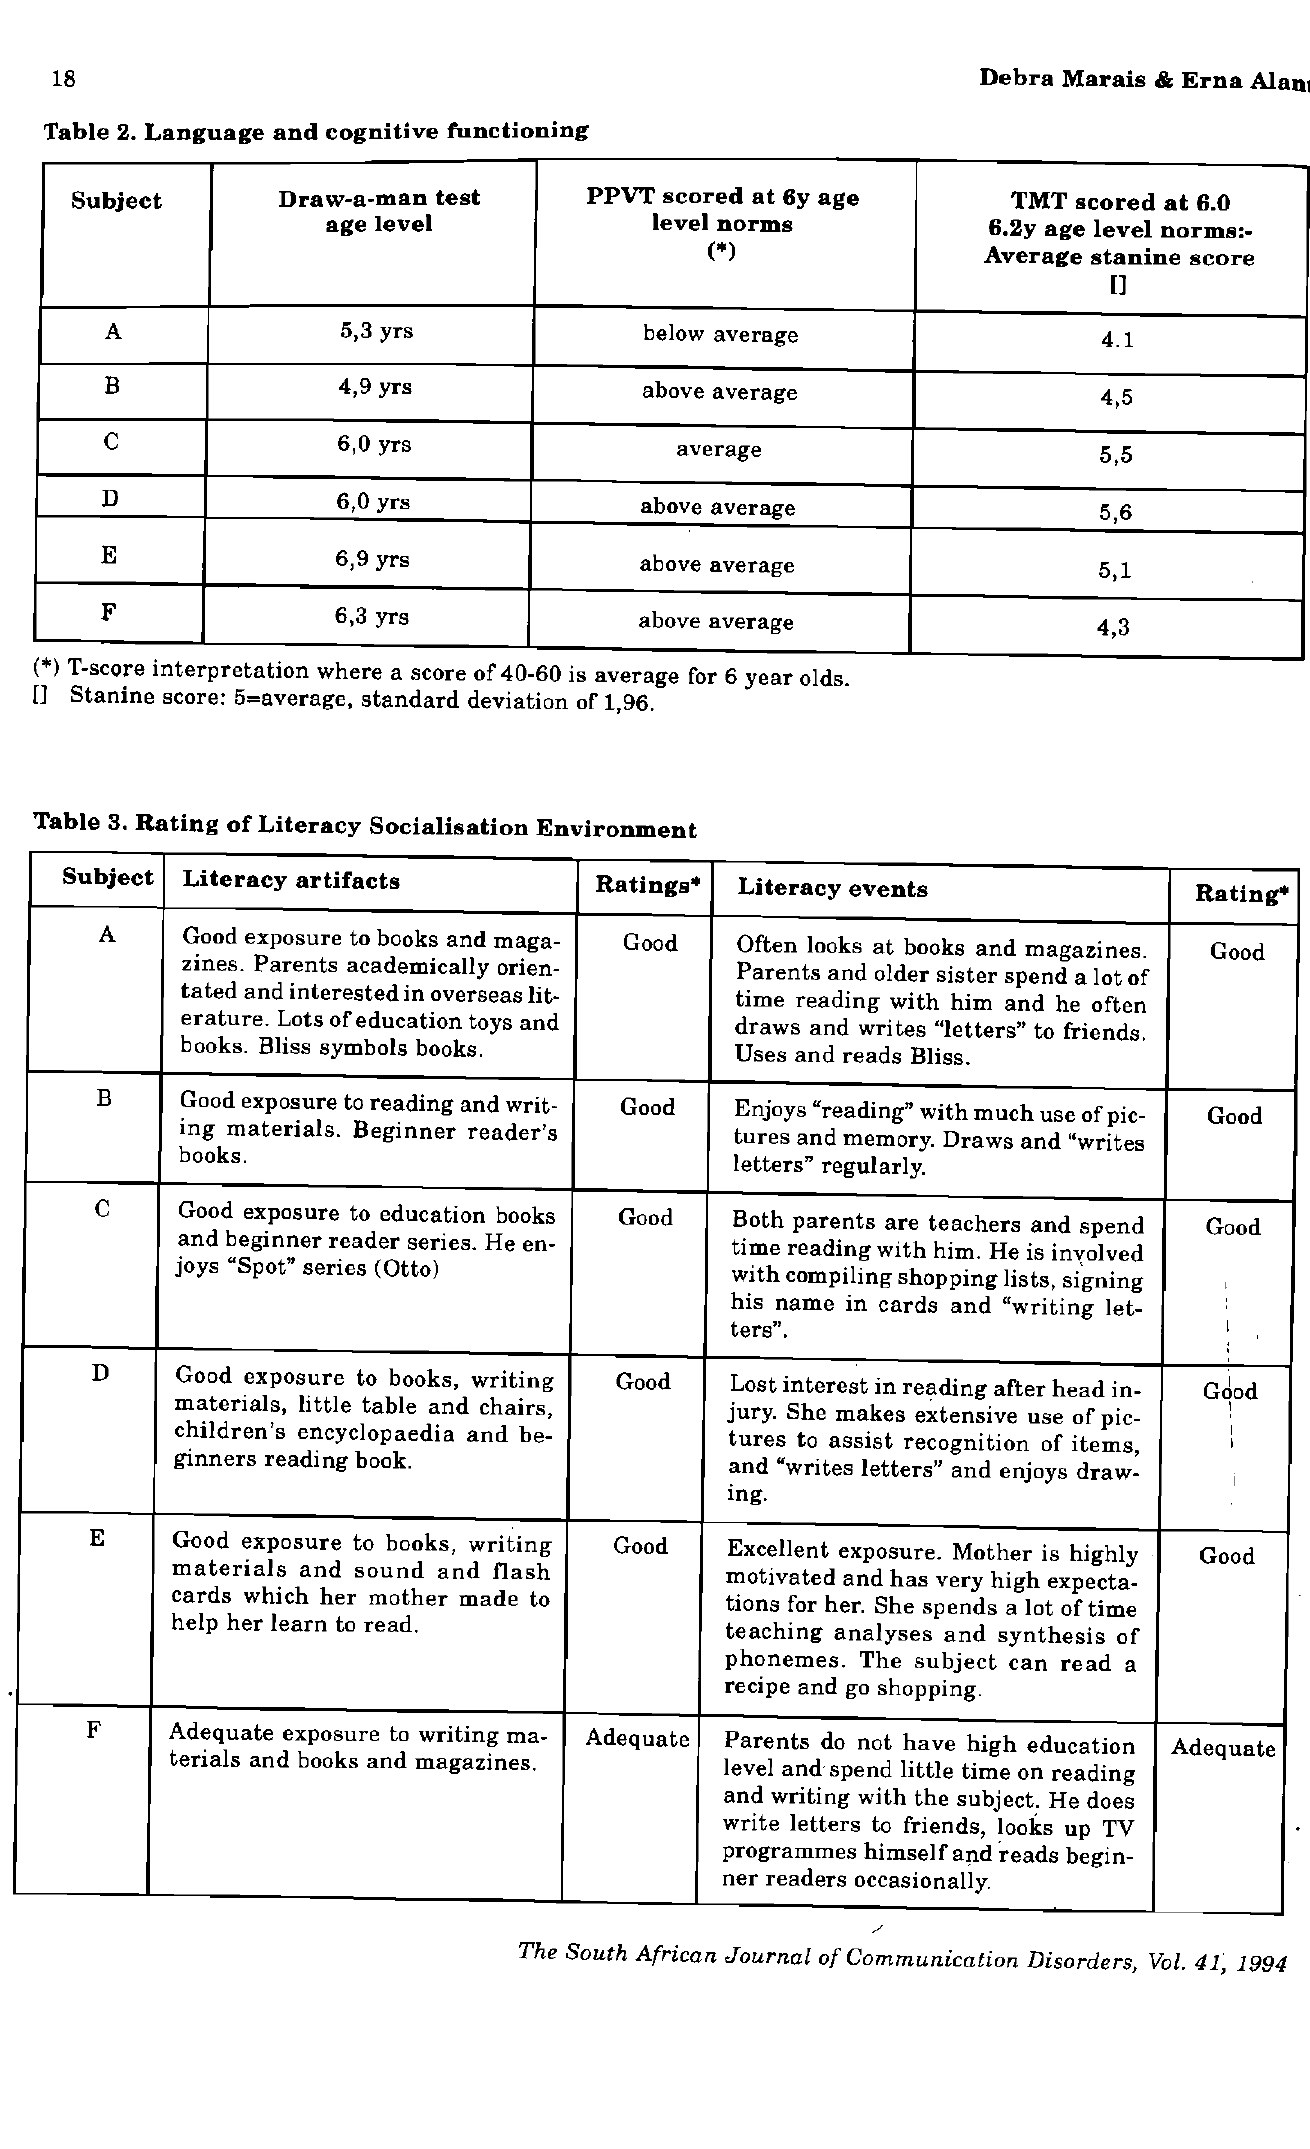
Table 2. Language and cognitive functioning